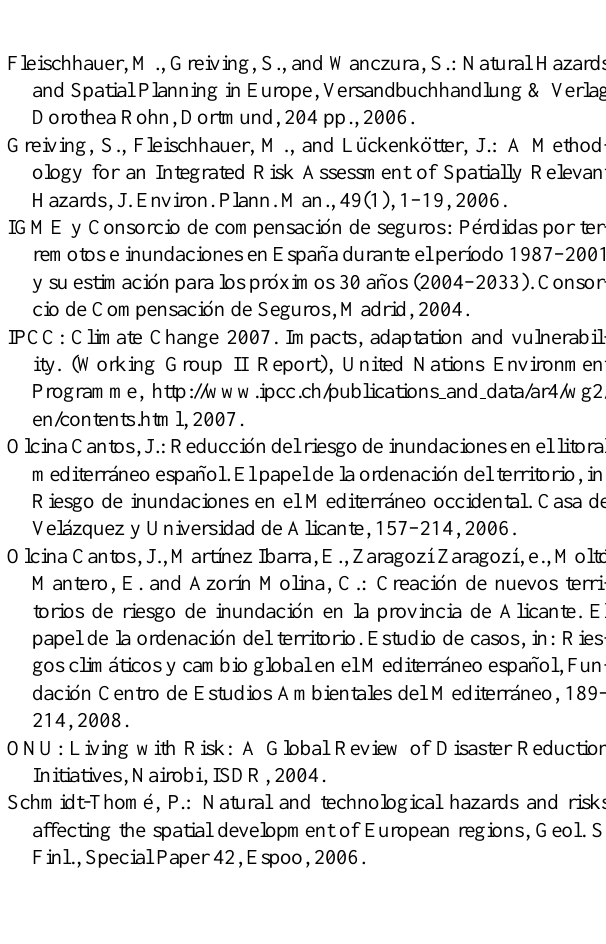
Fig. 3. Perception of flood risk by the inhabitants of three Alicante Figure 3. Perception of flood risk by the inhabitants of three Alicante towns .